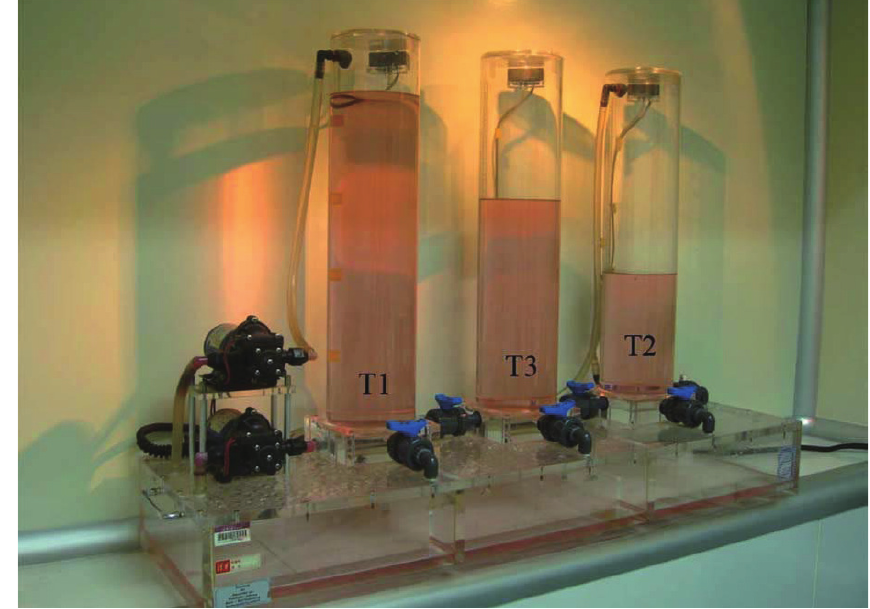
Figure 2. Structure of the three-tank system